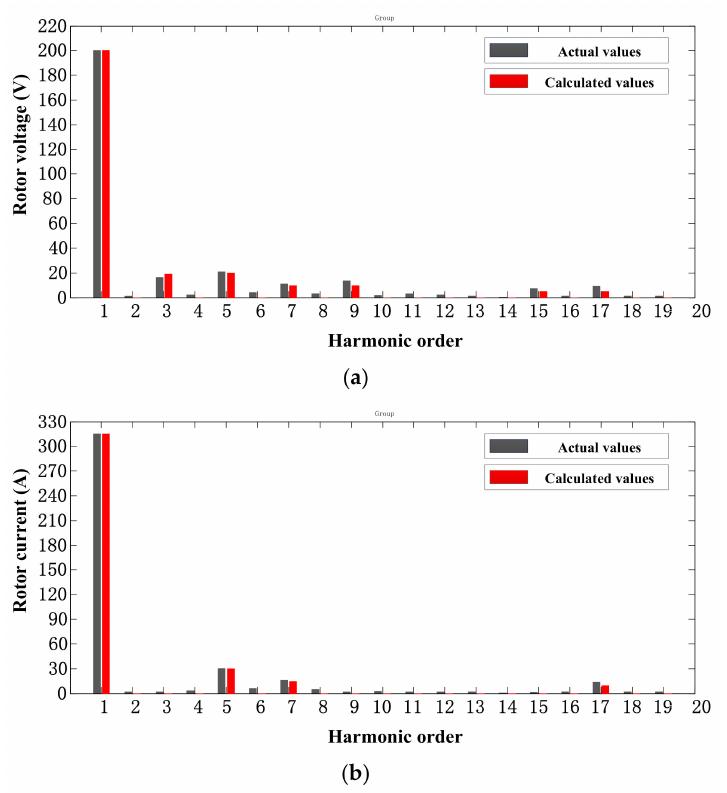
Figure 12. The actual and calculated value of rotor harmonics: ( a ) voltage harmonics; ( b ) current harmonics.